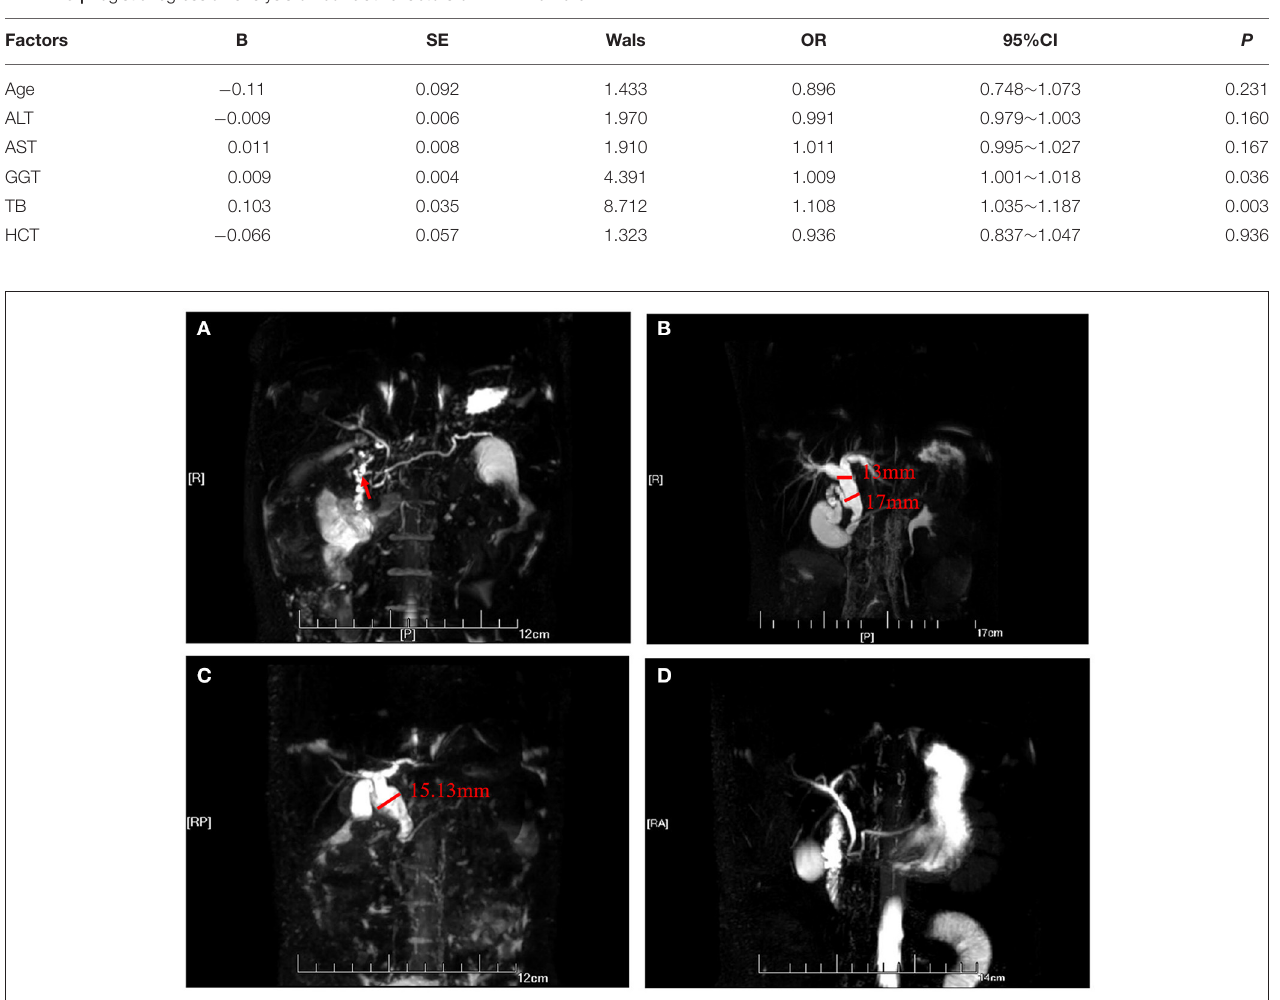
FIGURE 1 | MRCP diagram of pancreaticobiliary duct dysplasia. (A) The main pancreatic duct was slightly dilated, stiffed, and merged into the minor duodenal nipple. (B) The intrahepatic bile duct, common hepatic duct, and common bile duct were widened. The widest part of the common hepatic duct had a diameter of 1.3cm, and the diameter of the common bile duct was 1.7cm. The opening of the cystic duct confluence was a lower, and the confluence of the common bile duct and pancreatic duct was locally fusiform dilation. (C) The common bile duct was dilated, with a diameter of 15.13cm at its widest point. (D) The pancreatic ducts were widened, and the pancreaticobiliary ducts converged in advance. The length of the common duct was about 1.3cm.